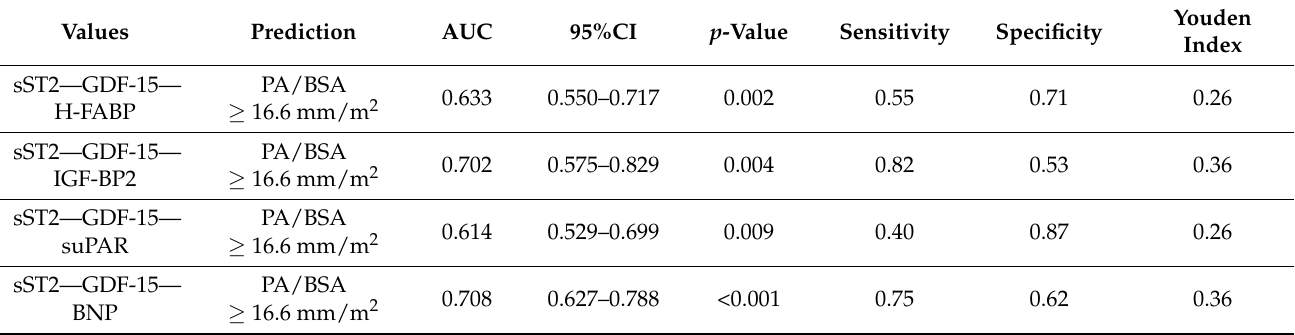
Table 6. Tabular overview of AUROC analyses of a combination of 3 biomarkers for prediction of a PA/BSA value ≥ 16.6 mm/m 2 with concerning Youden Index, sensitivity, and specificity .